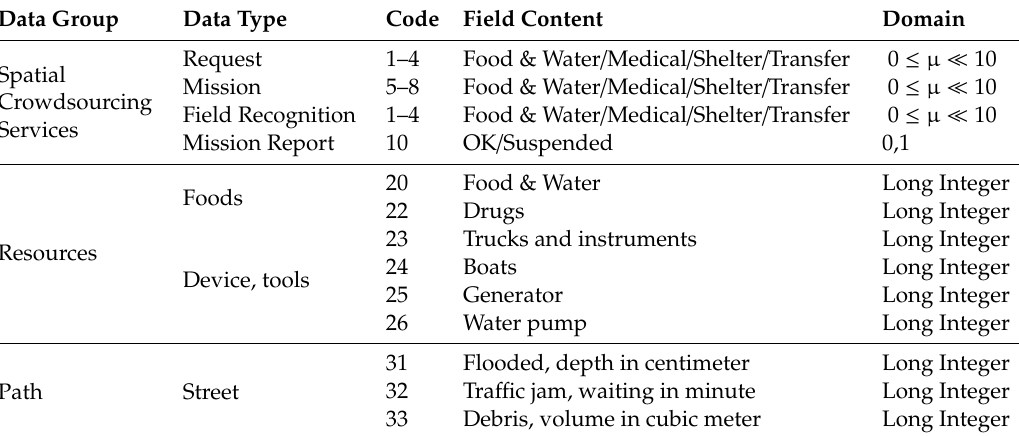
Table 1. Data codes which was used in Aqala flood relief